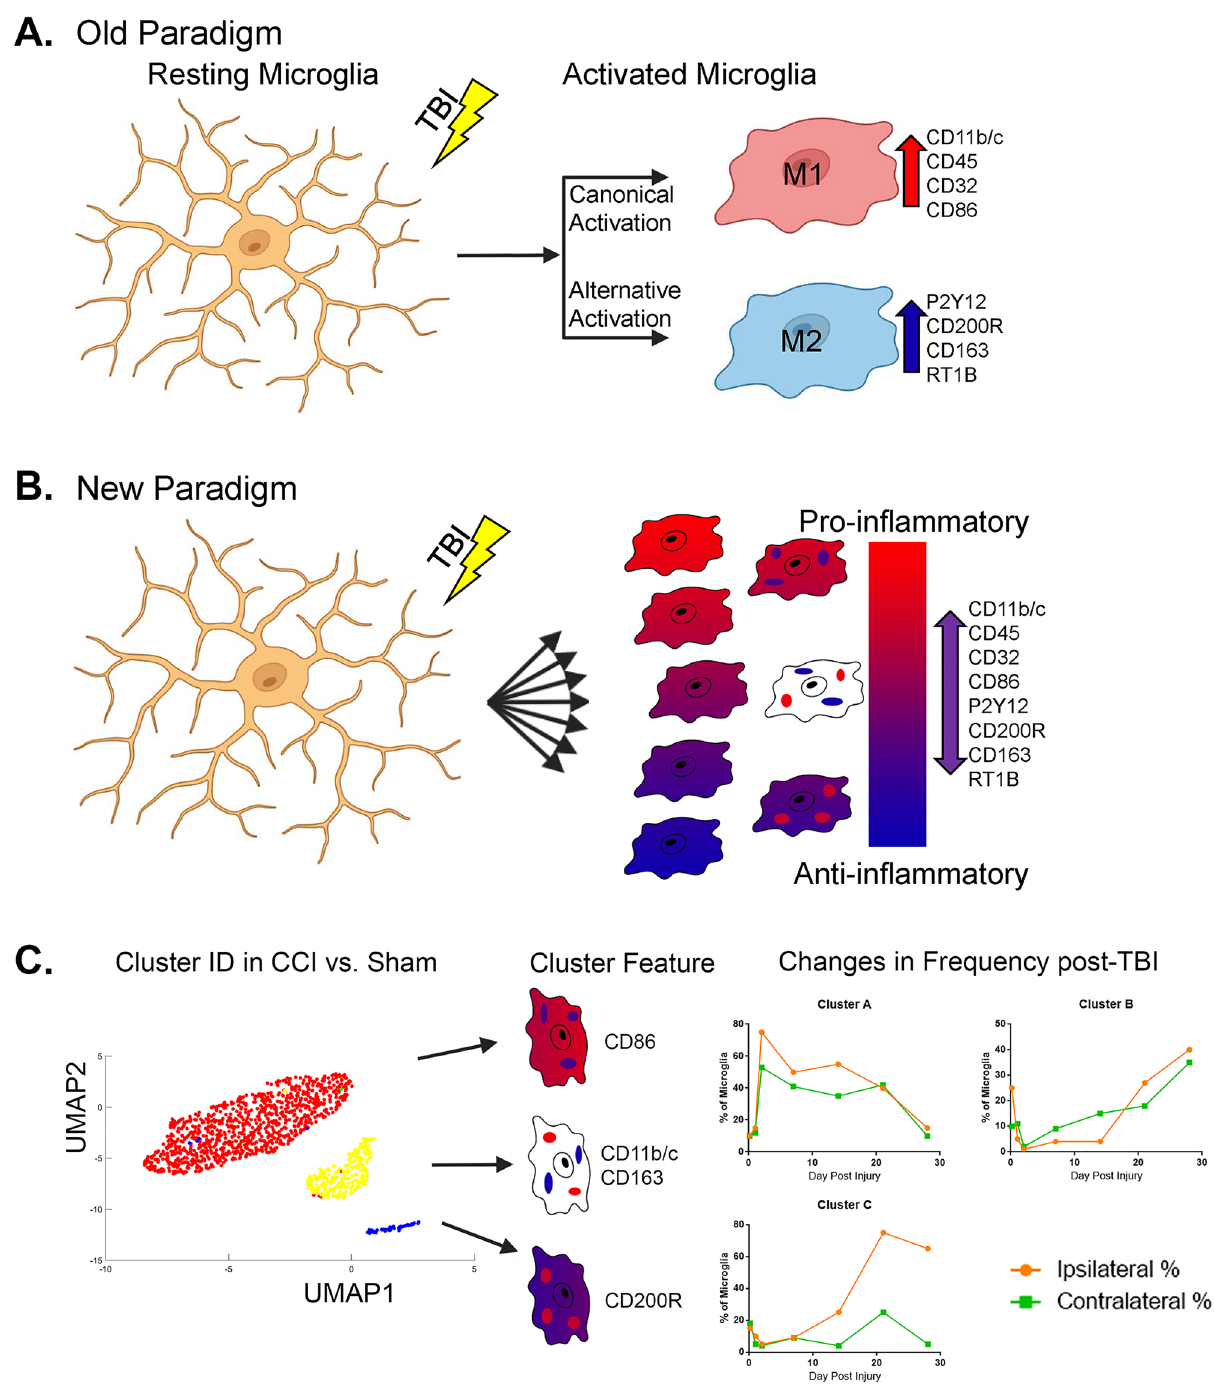
Figure 1. Microglial activation and process illustration. ( A ) According to the “Old Paradigm”, resting microglia are stimulated by a stimulus, such as a TBI, and proceed to become “Activated” along the “Canonical” or “Alternative” activation pathways to become either “M1” pro-inflammatory microglia with a specific surface marker profile, or “M2” anti-inflammatory microglia with a different surface marker phenotype. ( B ) In the “New Paradigm”, microglia are activated across a spectrum of pro- and anti-inflammatory activities and capable of expressing many combinations of surface markers according to cellular functions and not tied to a single pro- or anti-inflammatory phenotype. ( C ) We used cluster identification algorithms to find unique populations present in controlled cortical impact injured rats compared to sham-injured controls. These clusters were then characterized on the basis of their unique surface marker features. Finally, the changes in the distribution of microglia in each subpopulation was determined over time in both ipsilateral and contralateral hemispheres (simulated data